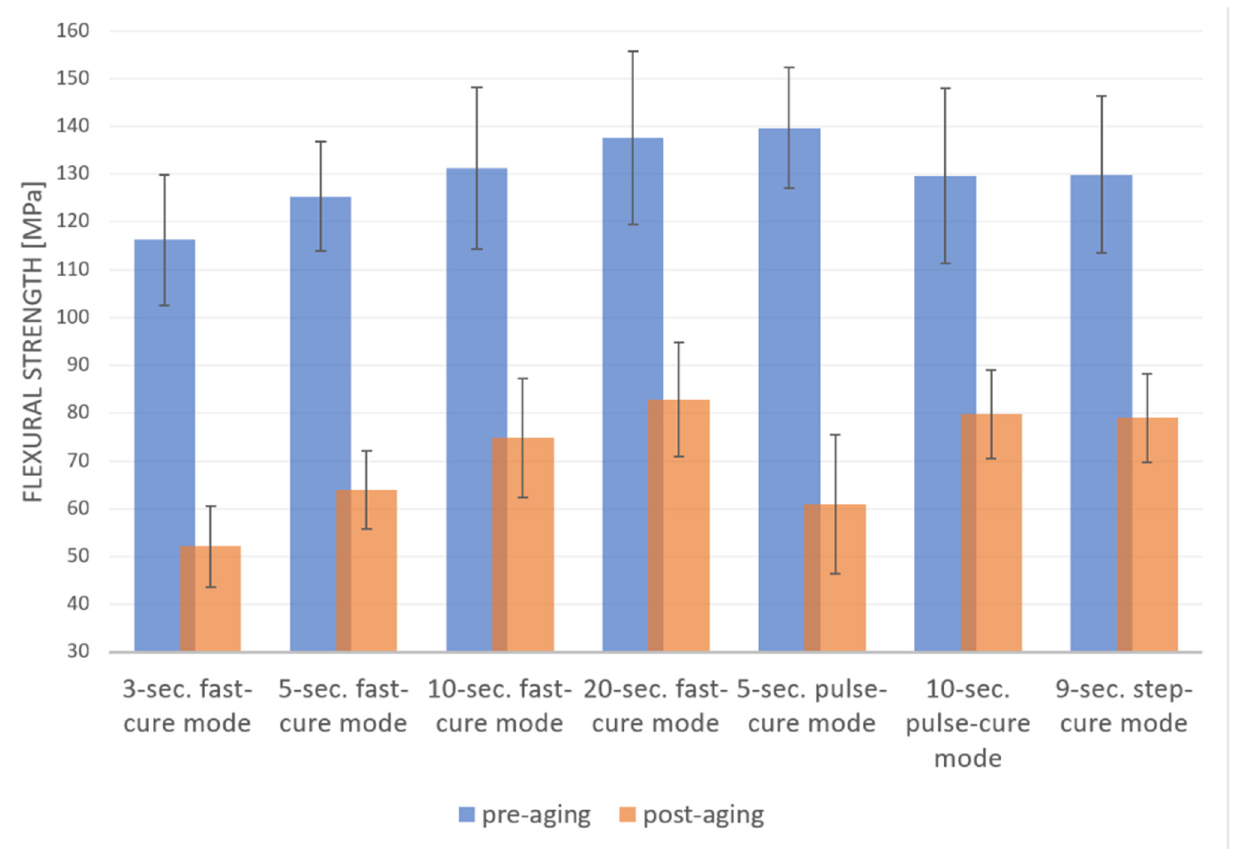
Figure 3. Mean flexural strength values (MPa) and standard deviation (error bars) (MPa) for photopolymerization mode and pre-/post-aging status.